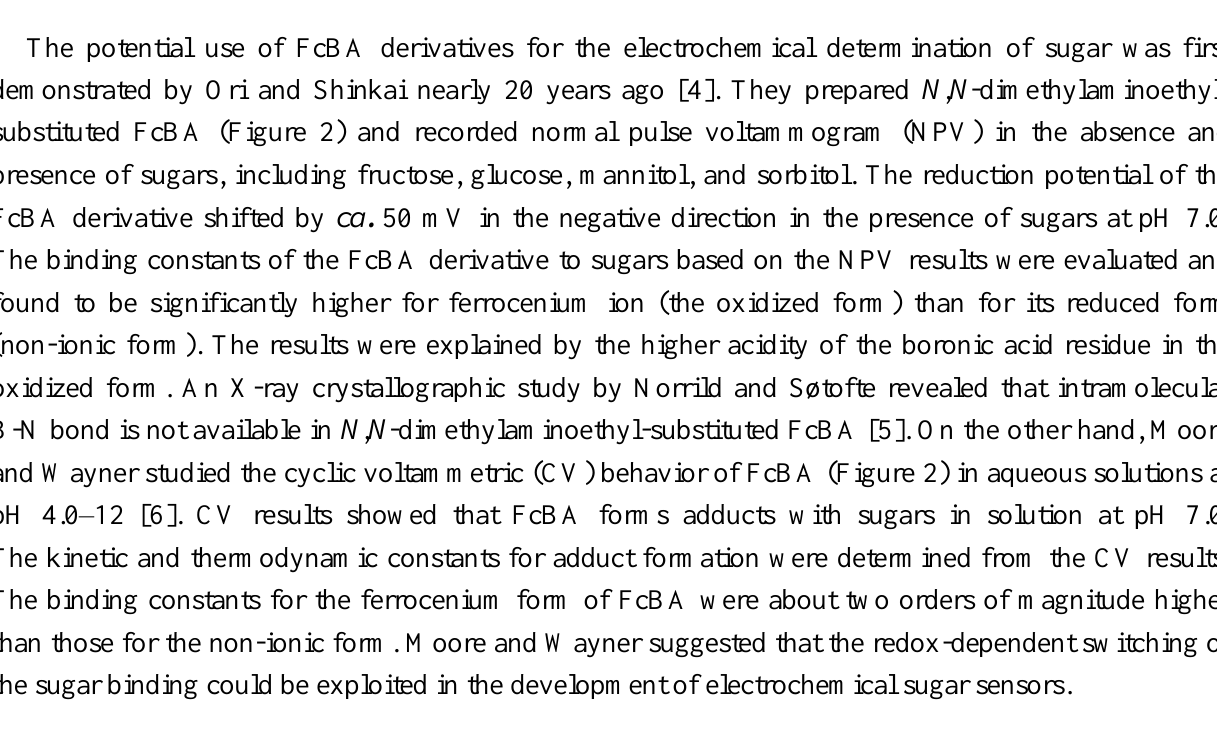
Figure 2. Chemical structures of ferroceneboronic acid and its